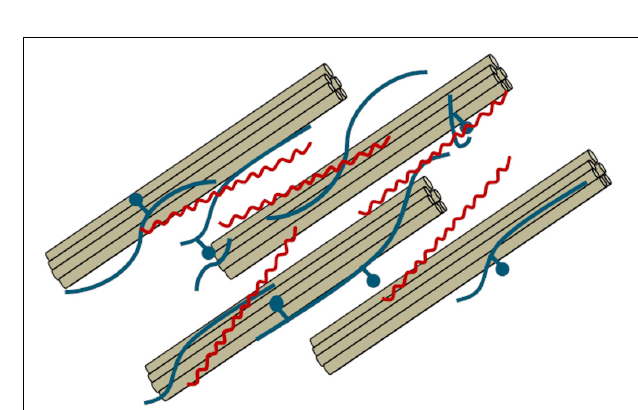
FIGURE 4 | Graphical description of cellulose microbifibrils (brown) surrounded by hemicellulose (blue) and pectin (red). Adapted from Cosgrove,